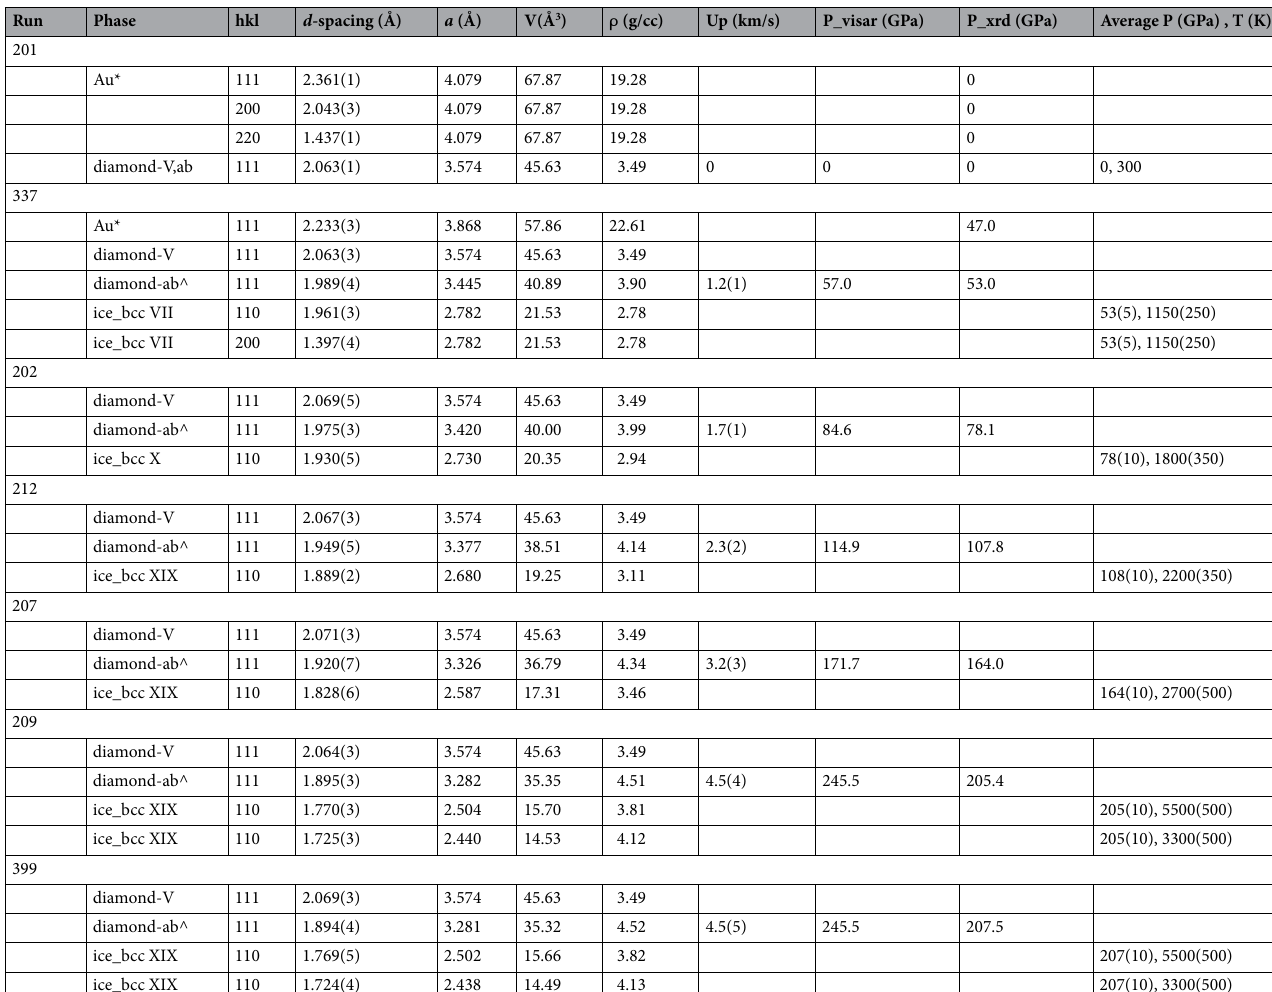
Table 1. Peak assignment and lattice parameters. V VISAR-side diamond, ab ablator-side diamond. *Pressure and temperature determined using Fei et al. 18 and Marsh 19 . ^Pressure determined using P-rho of McWilliams et al. 20 ; Knudson et al. 21 and Marsh 19 and LEOS9061 30